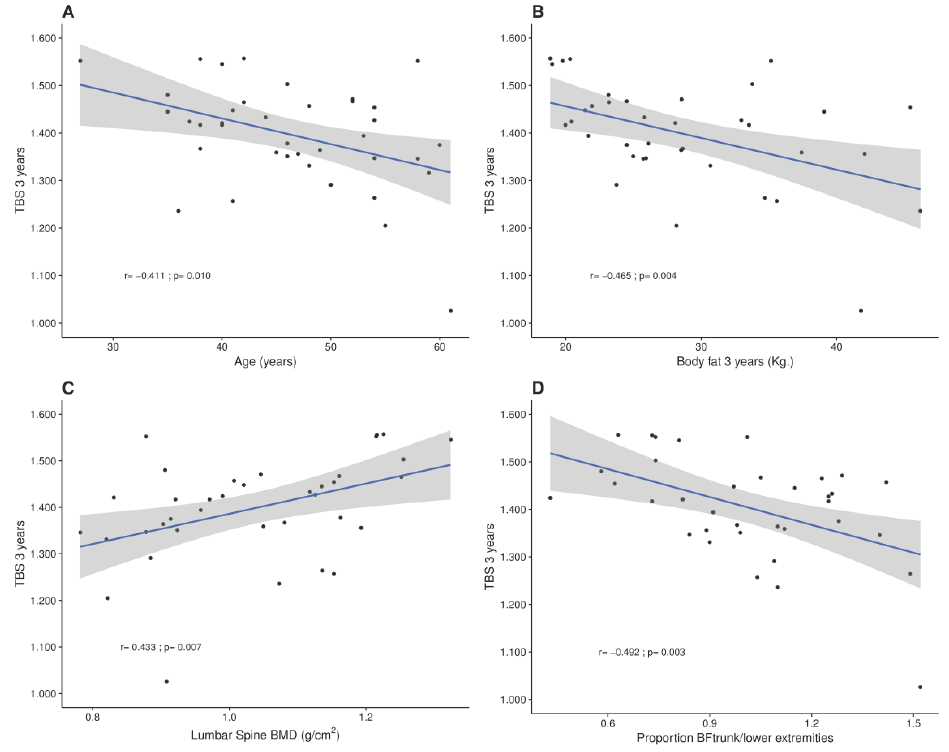
Figure 2. Correlations of TBS at three years after surgery with: ( A ) Age; ( B ) Body fat (BF); ( C ) LSBMD and ( D ) Body fat distribution trunk/versus lower extremities. Pearson correlation coefficients are included in each graph. Table 2. Bone measurements before and after gastric bypass.